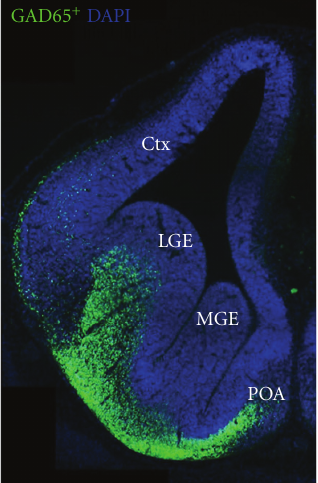
Figure 1: GABAergic interneurons are born in the basal telen- cephalon. Coronal cryosection of an E14 GAD65 EGFP mouse embryo. The MGE and the POA give rise to tangentially migrating cortical interneurons (green). GABAergic LGE-derived neurons migrate to the olfactory bulb, the striatum, and the lateral cortex. Ctx: cortex, MGE: medial ganglionic eminence, LGE: lateral ganglionic eminence, POA: preoptic